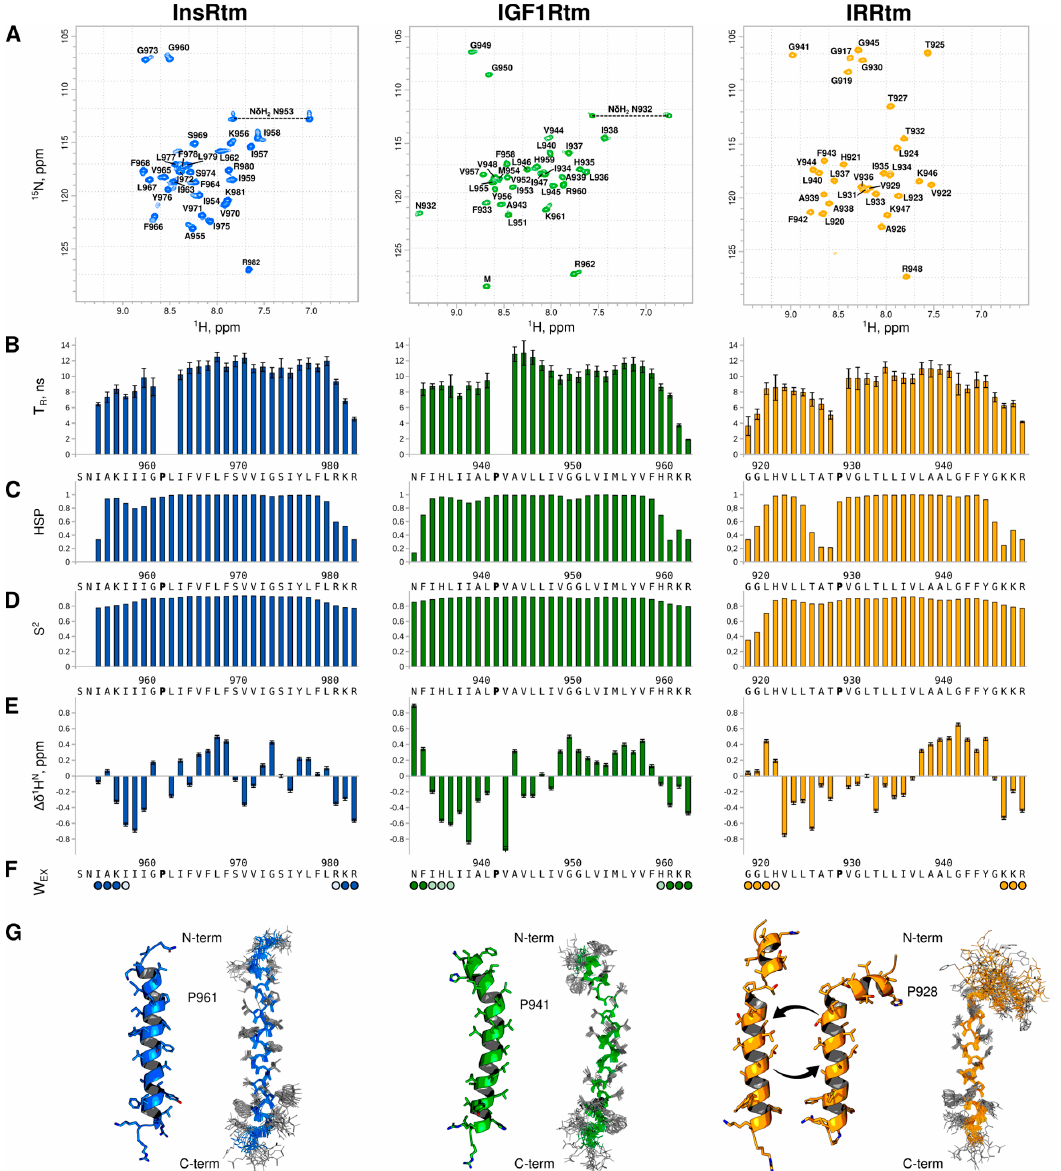
Figure 1. Comparison of structural–dynamic properties of InsRtm, IGF1Rtm, and IRRtm revealed by NMR studies in a membrane-mimicking environment. ( A ) 1 H/ 15 N-HSQC NMR spectra of TMDs (InsRtm in blue, IGF1Rtm in green, IRRtm in yellow) embedded into DPC micelles at D/P of 160, 313 K, and pH 6.7. The 1 H/ 15 N backbone and side-chain resonance assignments are marked. ( B ) The effective rotational correlation times, τ R , estimated using 15 N CSA/dipolar cross-correlated transverse relaxation experiment [34], suggest local mobility of the TMD amide groups. Uncertainties are shown by bars. ( C ) and ( D ) The helical structure probabilities (HSP) and local order parameters S 2 , respectively, calculated based on the backbone chemical shifts [35], are indicative of helical structure distribution for TMDs and its stability along the peptide sequence. ( E ) The 1 H N secondary chemical shifts, ∆ δ 1 H N , are related to a variation of the length of the hydrogen bond, in which amide proton participates [36]; the local increase in ∆ δ 1 H N is specified in the shortening of the given hydrogen bond, and vice versa. ( F ) Accessibility of TMD backbone amide protons to water (W ex ) is assessed by detection of strong (solid circles) and weak (open circles) cross-peaks observed in CLEANEX spectrum [37]. ( G ) Ribbon diagrams (left) and an ensemble of 20 NMR-derived structures (right) of InsRtm (PDB 7PHT), IGF1Rtm (PDB 7PH8), and IRRtm (PDB 7PL4) embedded into DPC micelles. Bonds between heavy atoms are